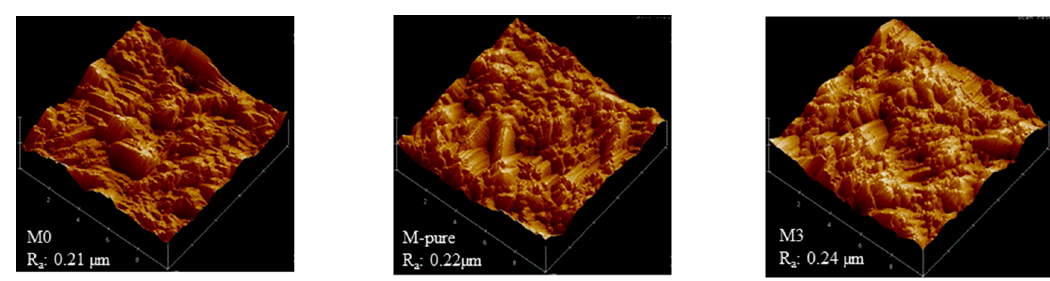
Figure 6. AFM images of M0, M ‐ pure and M3 membranes.